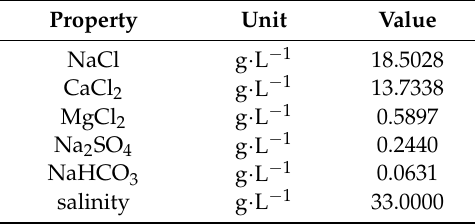
Table 2. Properties of simulated brine